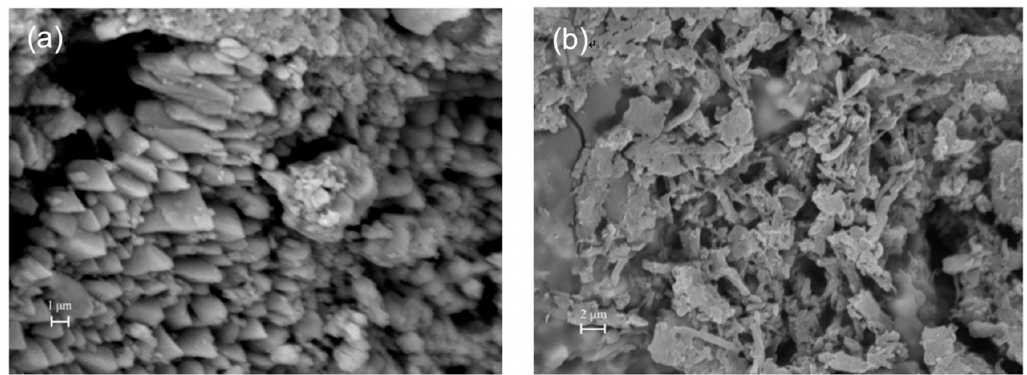
Figure 9. SEM images of a carbonate stone substrate before ( a ) and after ( b ) coating. Table 2. The amount of water absorbed at different absorption times by a carbonate stone before and after coating, and the corresponding inhibition efficiency.